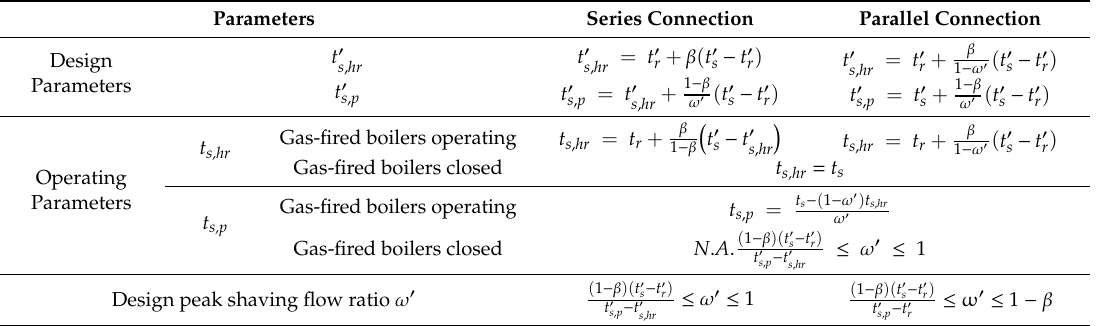
Table 1. The supply water temperatures of the heat exchanger and peak shaving gas-fired boilers as well as the determination of the design peak shaving flow ratio ω (cid:48) .